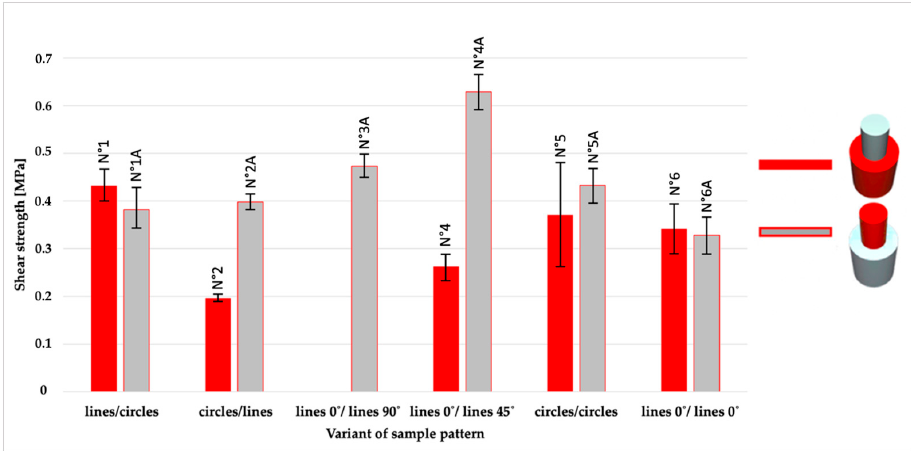
Figure 8. An overview of average shear strength for 11 series of samples (different configuration of patterns and material sequence).